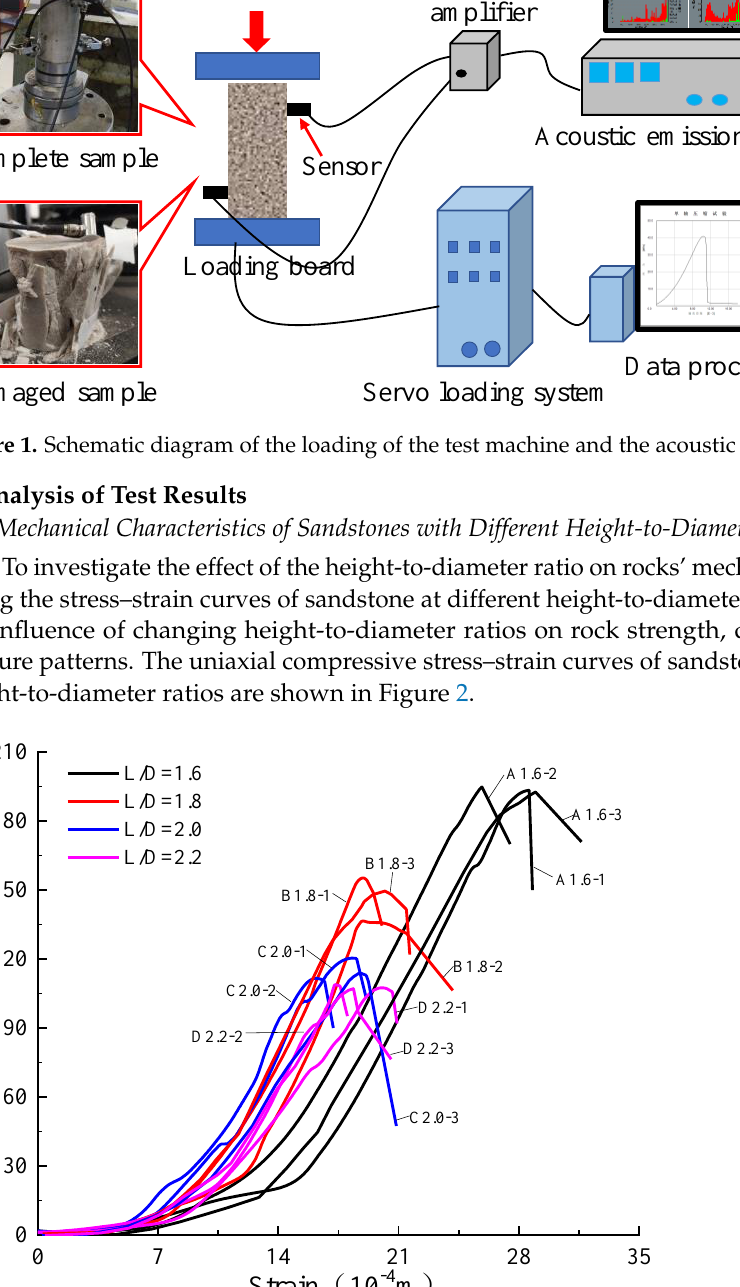
Figure 1. Schematic diagram of the loading of the test machine and the acoustic emission system.